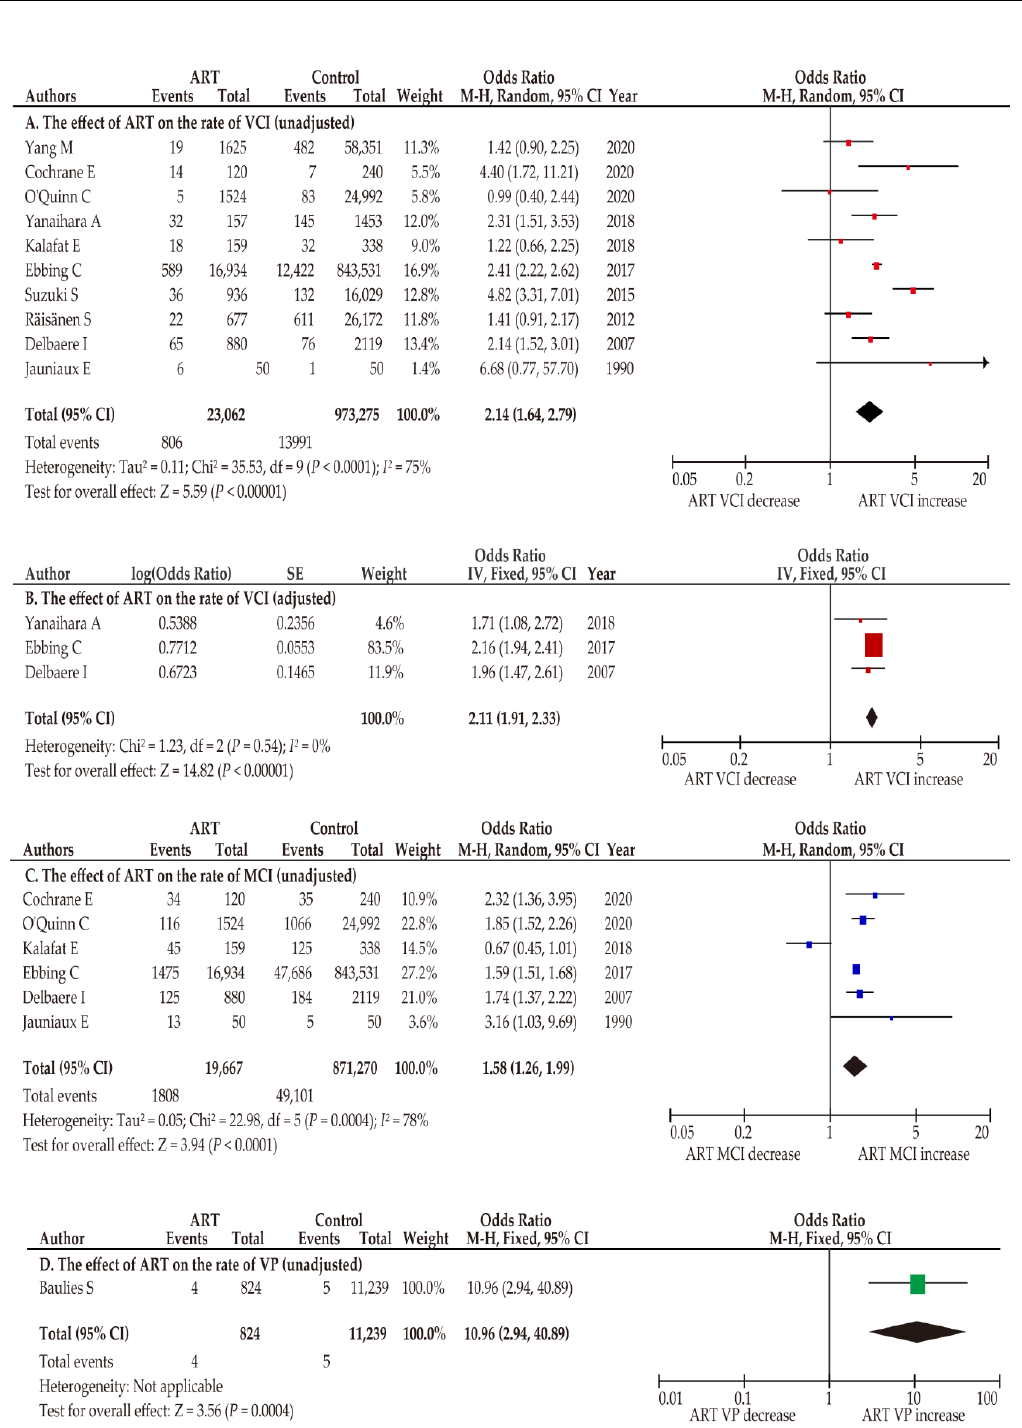
Figure 2. Effect of ART on the prevalence of ACI. Pooled odds ratios (ORs) were calculated using RevMan version 5.4.1 (Cochrane Collaboration, Copenhagen, Denmark); thus, some values may be slightly different from their original state. The position of the colored box is a point of the estimated OR. The effects of ART on the following conditions were determined through unadjusted or adjusted analyses: ( A ) VCI, ( B ) VCI (adjusted), ( C ) MCI, and ( D ) VP. Forest plots were ordered according to the year of publication. Substantial heterogeneity was observed in the unadjusted analyses (( A ), I 2 = 75%; ( C ), I 2 = 78%) whereas no heterogeneity was observed in the adjusted analysis (( B ), I 2 = 0%). Abbreviations: ACI, abnormal cord insertion; VCI, velamentous cord insertion; MCI, marginal cord insertion; VP, vasa previa; ART, assisted reproductive technology; OR, odds ratio; CI, confidence interval; SE, standard